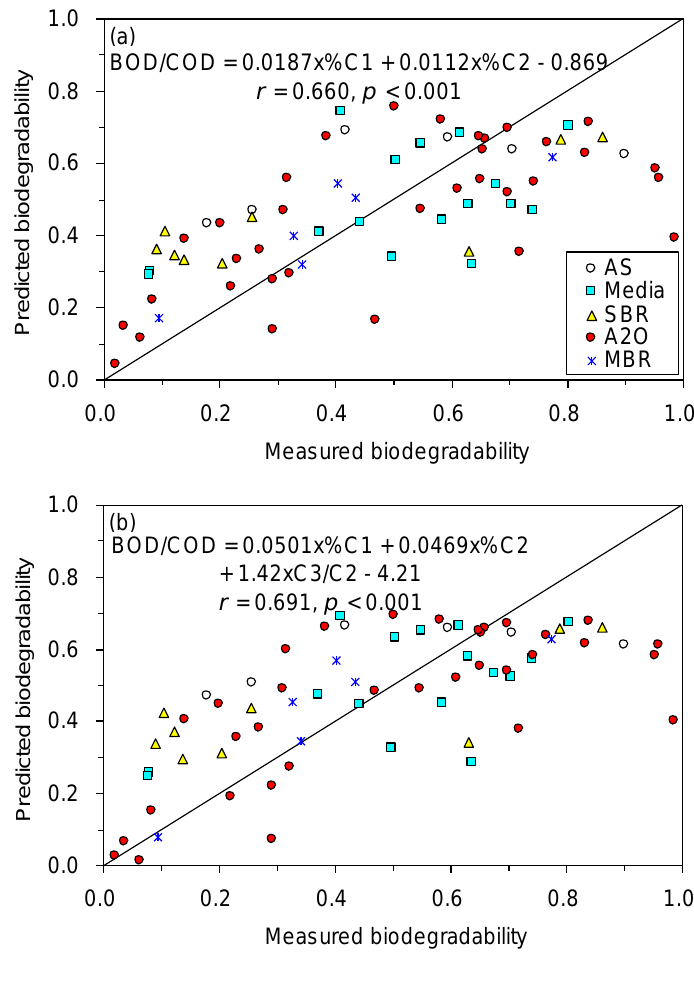
Figure 6. Correlations between the measured biodegradability of TOC (BOD/COD) and the predicted biodegradability by multiple regression methods based on ( a ) %C1 and %C2, and ( b ) %C1, %C2 and